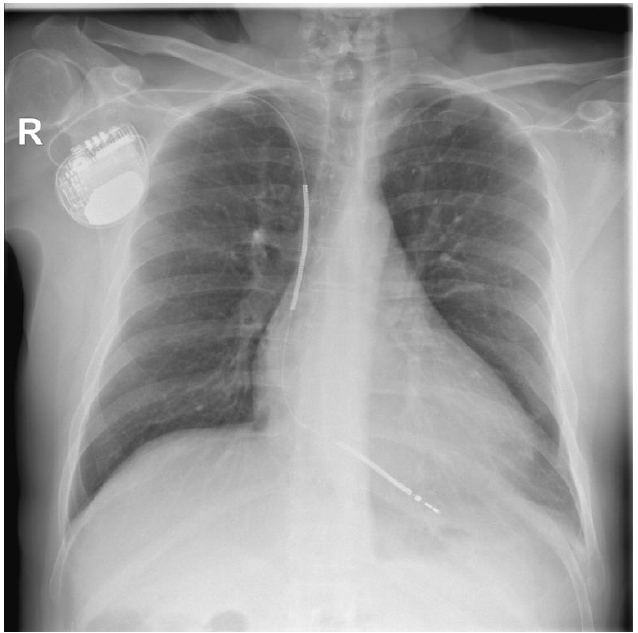
Figure 4. Chest X-ray with new defibrillator on the right side of the chest and the lead implanted through the right subclavian vein.